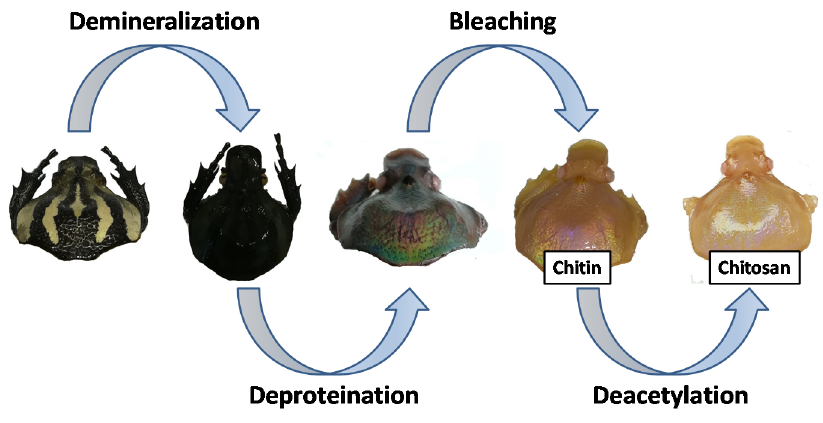
Figure 1. General concept for chitosan preparation from G. orientalis .